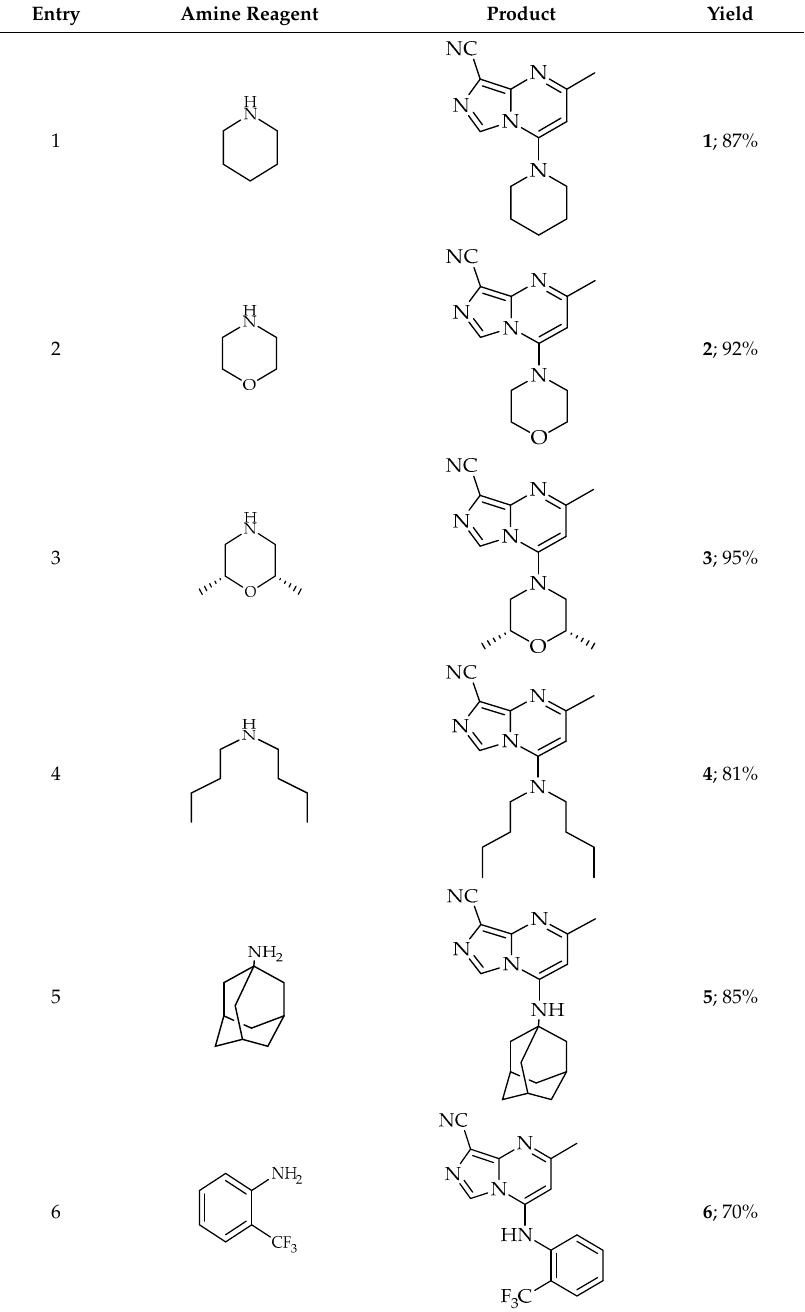
Table 1. Results of the S N Ar on 4-chloro-2-methylimidazo[1,5- a ]pyrimidine-8-carbonitrile with various amines.